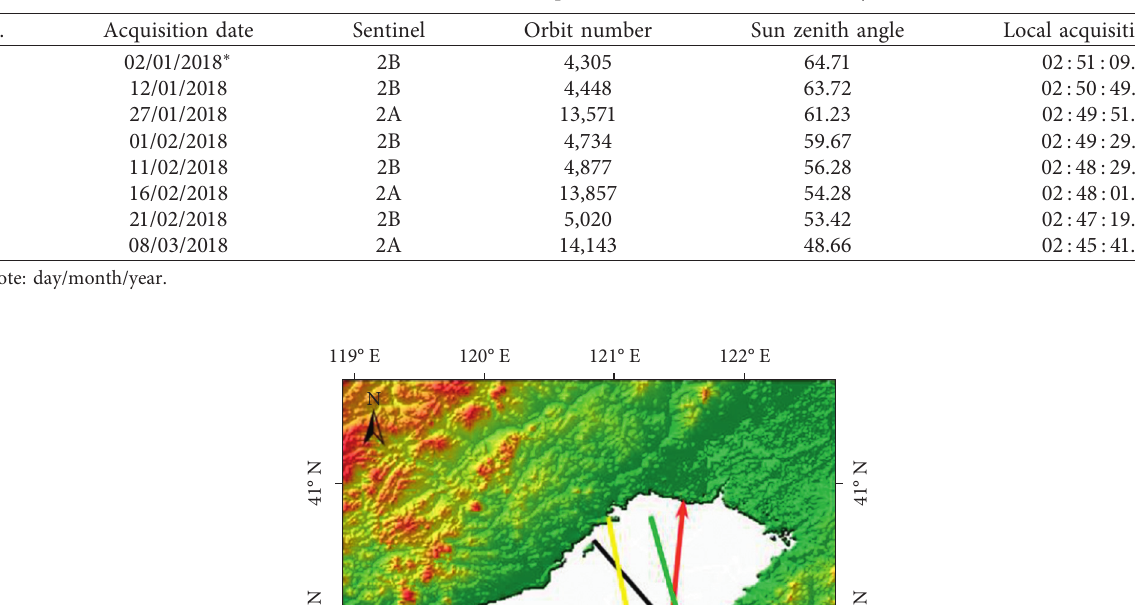
Table 2: Sentinel-2A/2B experimental data used in this study.